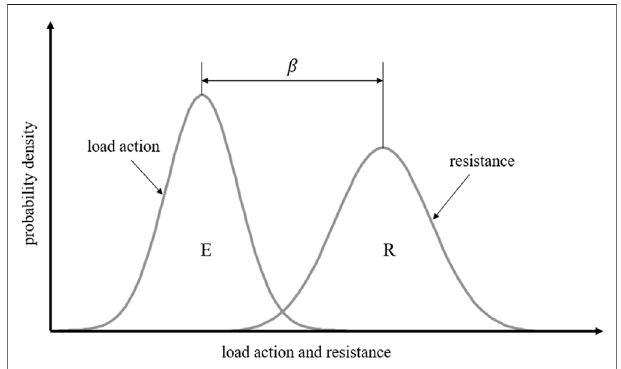
FIGURE3| Relationshipbetweenreliabilityindexand probabilitydensity functions.